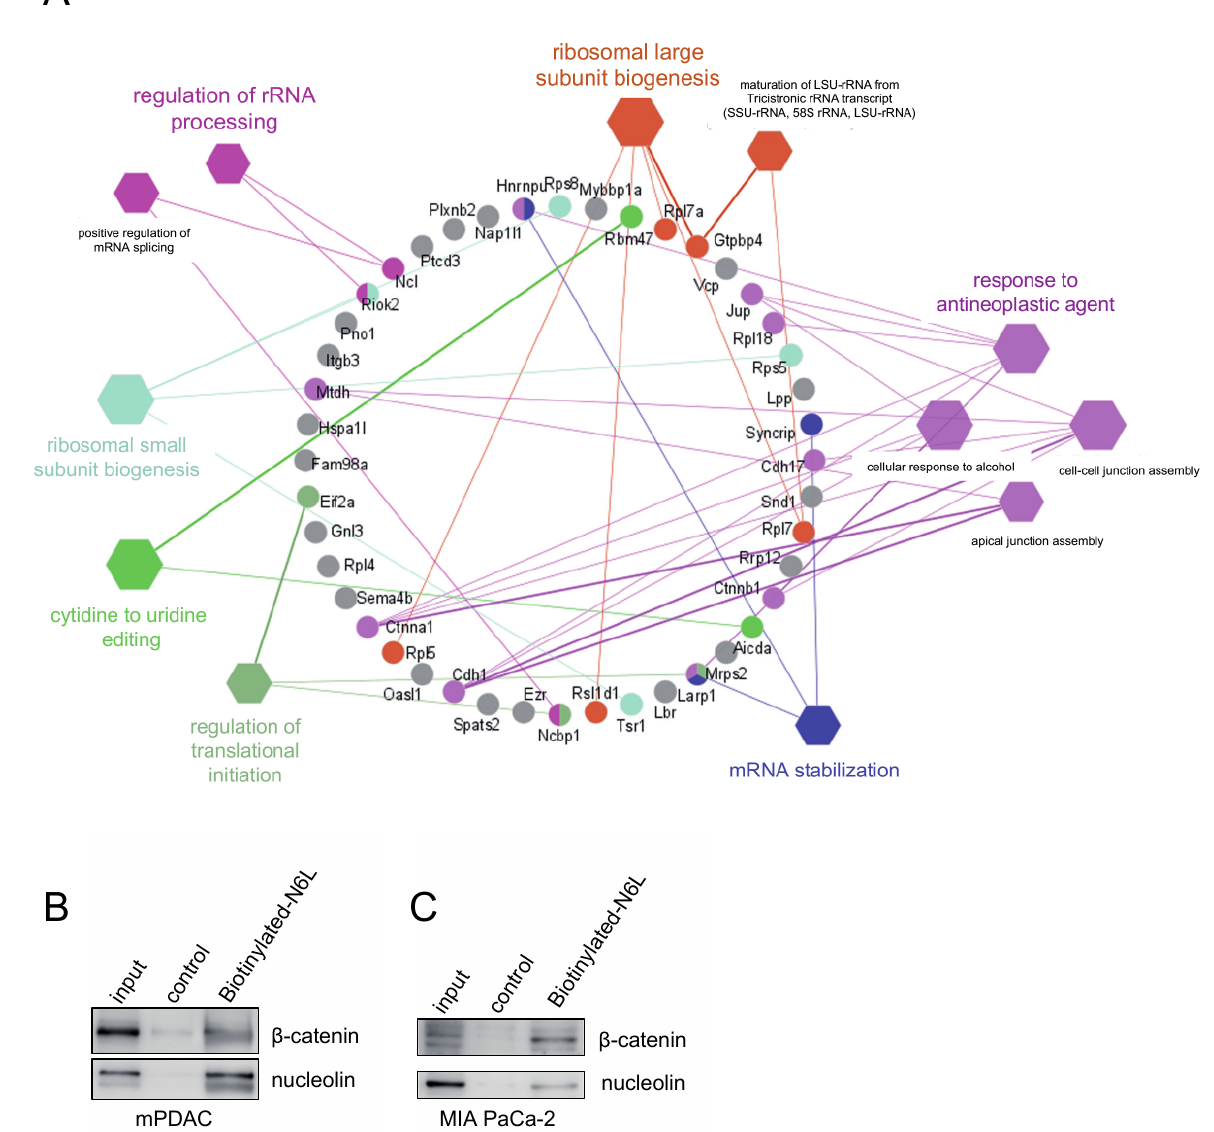
Figure 1. Proteins from N6L pull-down and their biological functions. ( A ) ClueGO network of non-redundant biological processes for N6L interactome (Cytoscape version 3.8.0, ClueGO version 2.5.6/CluePedia/GO_BiologicalProcess-EBI-UniProt-GOA_21.04.2020 with 21201 references). Functionally grouped network with terms (in hexagons) as nodes linked based on their kappa score level ( ≥ 0.4), where only the label of the most significant term per group is shown. The hexagon node size represents term p -value corrected with Bonferroni step-down level ( ≤ 0.05) (larger size for lower p -value). The nodes in the circle represent the genes and the edges represent the links with the biological process group. Functionally related groups partially overlap for the same gene. Gene terms not related to a functional group are shown in grey. ( B , C ) Western blotting of N6L pull-down. The cell lysate of the extranuclear cellular fraction (input), the biotinylated N6L pull-down and the control biotin pull-down of mPDAC and MIA PaCa-2 cells were analyzed by Western blotting with anti-nucleolin and anti- β -catenin antibodies.